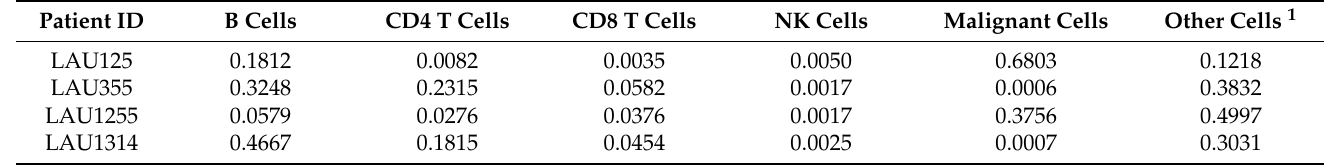
Table 1. Fractions of cell types measured using flow cytometry for the lymph nodes of metastatic melanoma patients (modified from Supplementary Table S3A of [23]).